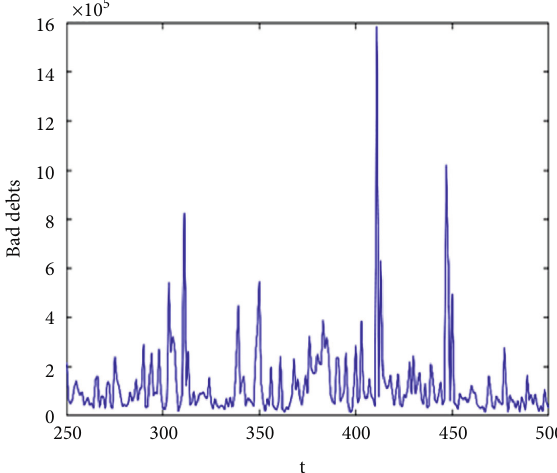
Figure 6: Time series evolution of the number of bad debts.